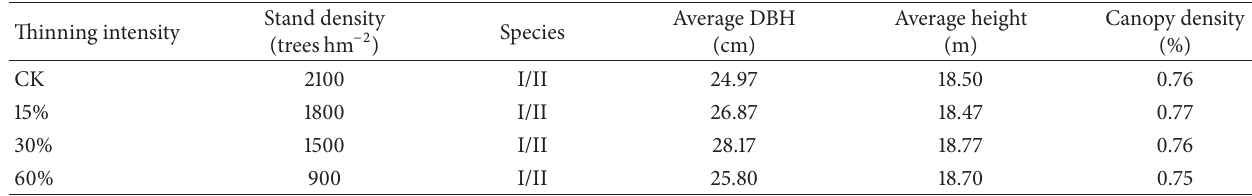
Table 1: Stand characteristics of the standard plots.